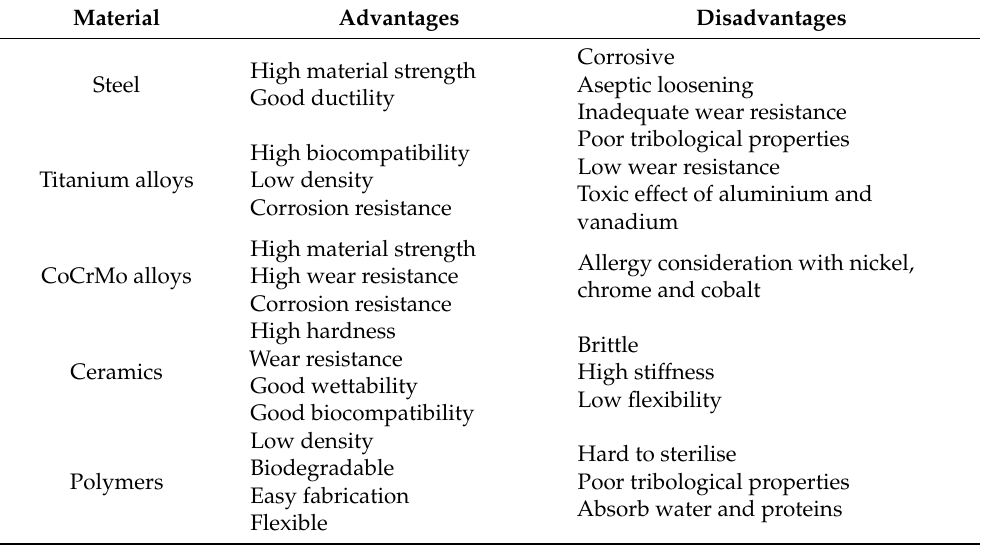
Table 3. Advantages and disadvantages of biomaterials